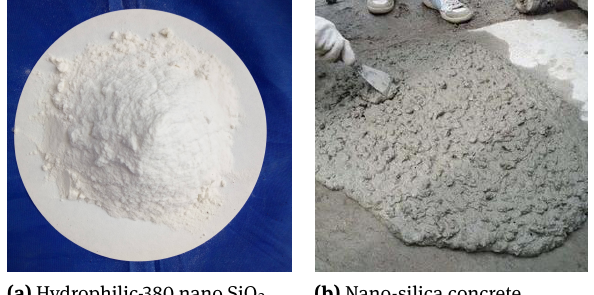
Figure 4: Nano-silica concrete preparation